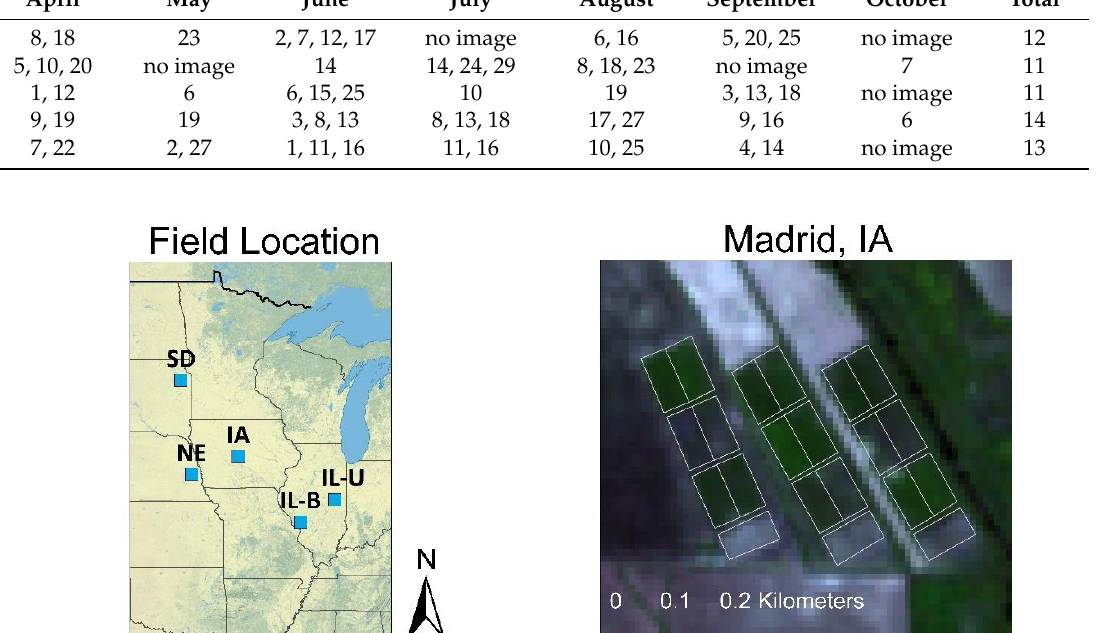
Figure 3. Sentinel-2 multispectral imagery of the study sites displayed in true color. Brighton, Illinois (IL) (day-of-year (DOY) 169); Urbana, IL (DOY 281); Madrid, Iowa (IA) (DOY 177); Ithaca, Nebraska (NE) (DOY 165); and South Shore, South Dakota (SD) (DOY 193). Table 3. Summary of imagery considered for model development. Site